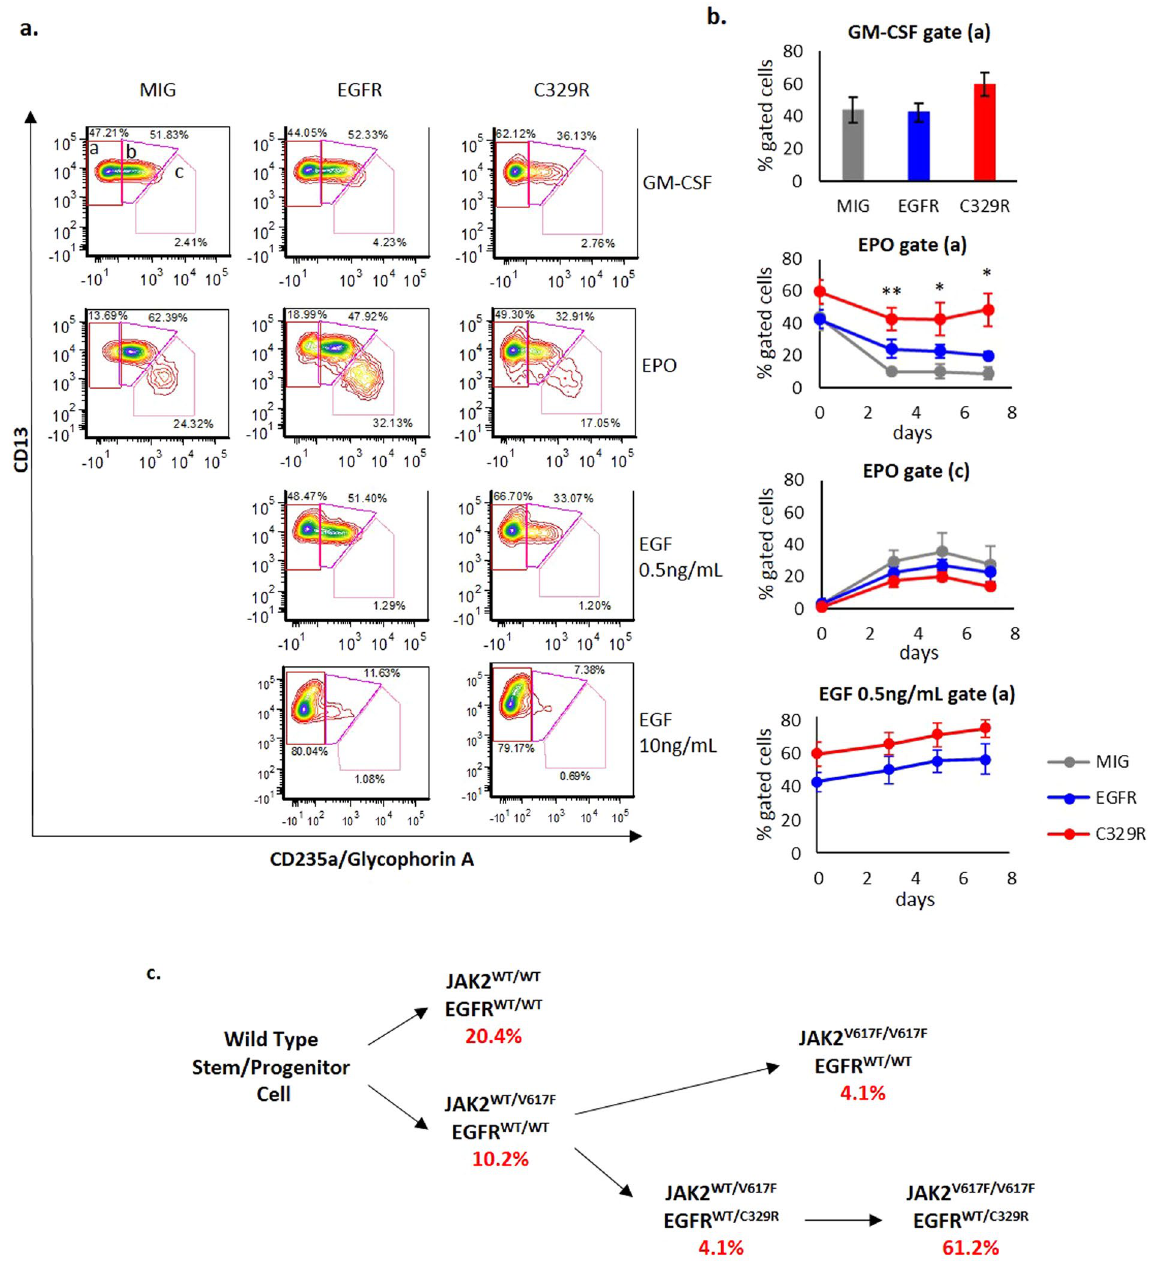
Figure 3. The EGFR C329R mutant impairs erythroid differentiation in the human TF1.8 erythroleukemia cell line. ( a ) Dot plots representative of CD235a (glycophorin A, erythroid marker) and CD13 (myeloid marker) surface expression on TF1.8/MIG, TF1.8/EGFR and TF1.8/C329R cells on day 5 of culture with GM-CSF (5 ng/ mL), EPO (5 U/mL) or rhEGF (0.5 ng/mL or 10 ng/mL). ( b ) Percentage of cells in gates (a) or (c) (identified in (Fig. 3a) in GM-CSF culture (top panel), and plotted over a 7 day time-course for EPO (middle panels) or EGF (bottom panel) containing cultures. Points represent mean ± SE of 3 independent experiments. T-test * P < 0.05, ** P < 0.01 (MIG vs. C329R). ( c ) Schematics of temporal acquisition of mutations (originating from a WT stem/progenitor cell) as determined from genotyping of individual BFU-E colonies plated from PBMNC. The percentage of each clone in PBMNC is